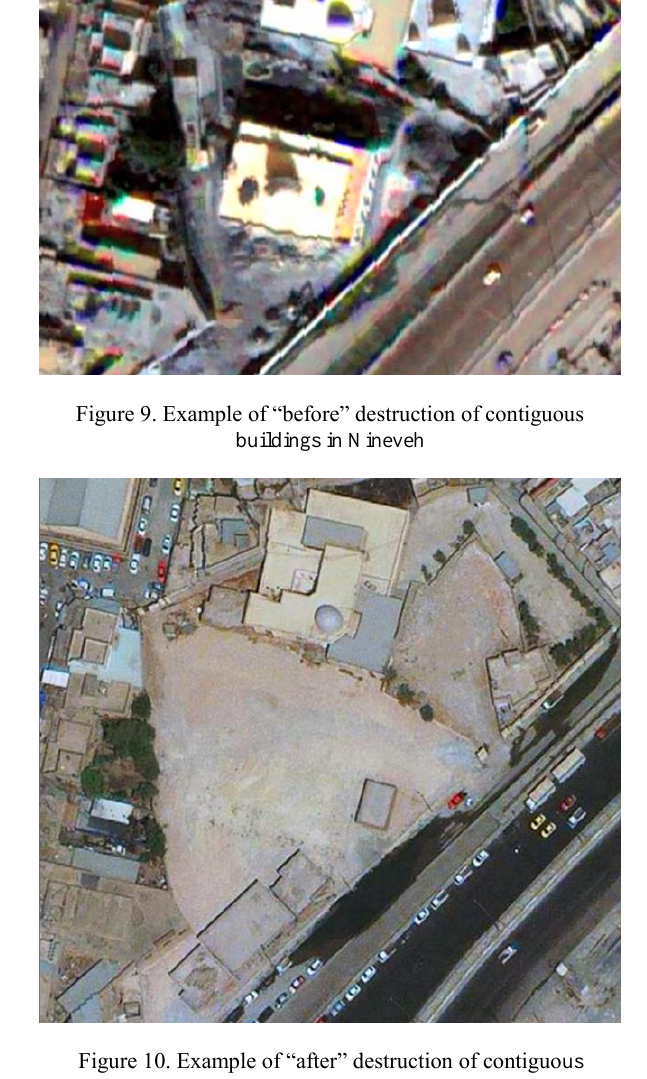
Figure 10. Example of “after” destruction of contiguous buildings in